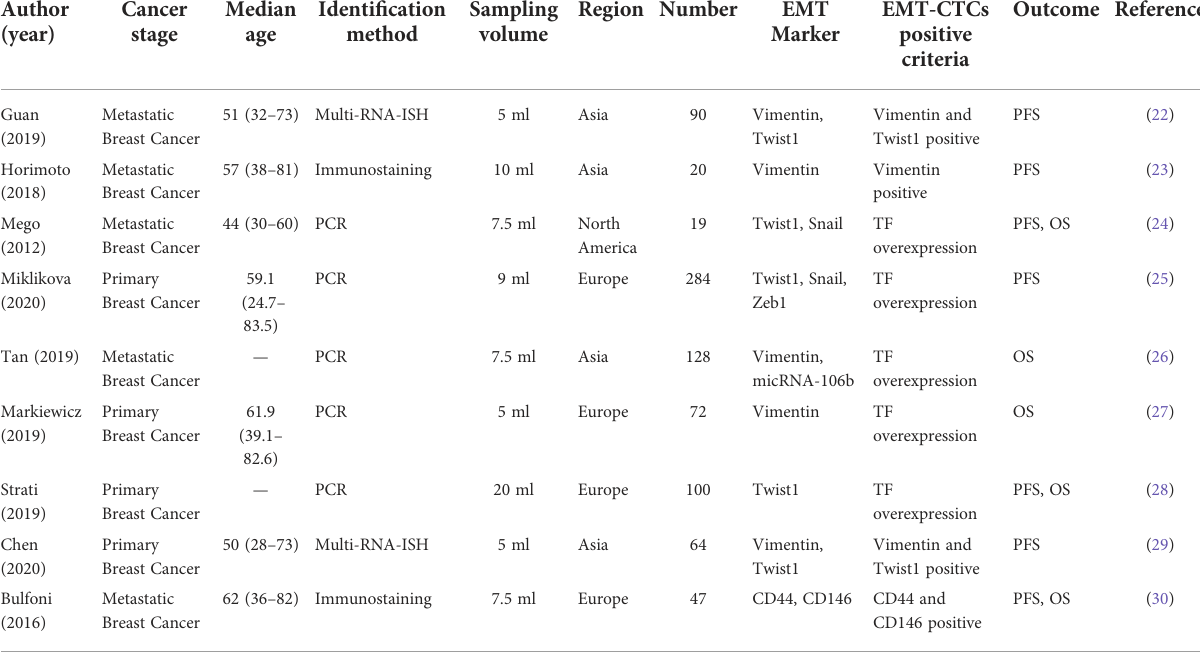
TABLE 1 The detailed information of the included